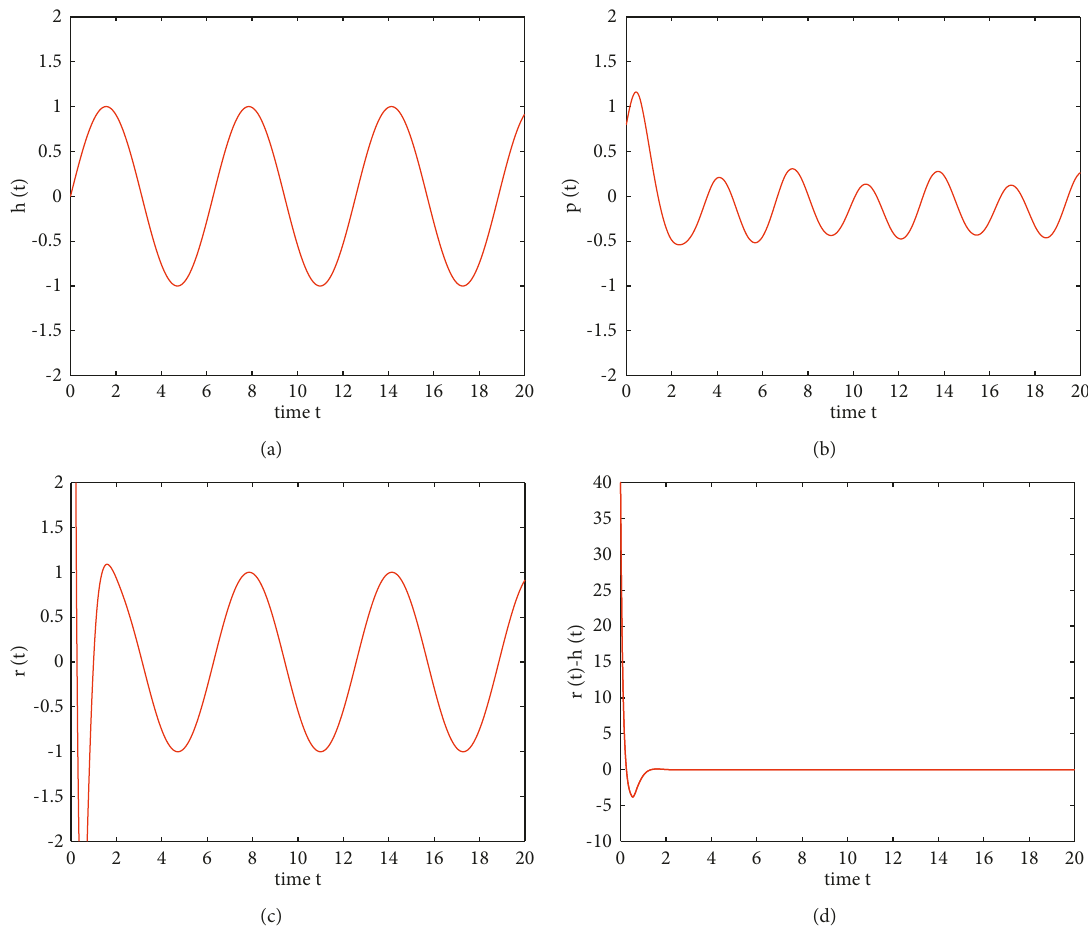
Figure 14: (a) The information signal; (b) the transmitted signal; (c) the recovered signal; (d) the error between the information signal and the recovered